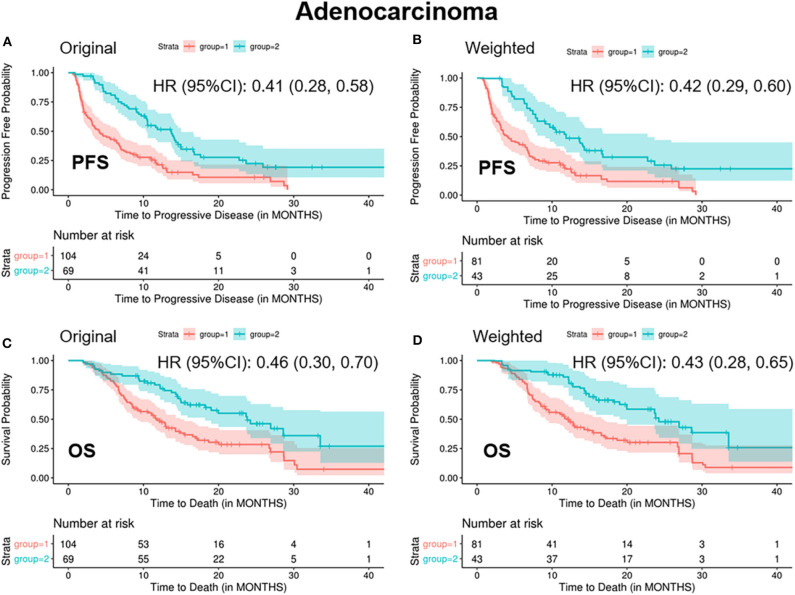
Kaplan-Meier curves of PFS/OS in the original and weighted sample of adenocarcinoma. group 1: meaningful improvements in <2 out of 4 biomarkers (CEA, CA125, CYFRA21-1, and SCC-Ag); group 2: meaningful improvements in ≥2 out of 4 biomarkers (CEA, CA125, CYFRA21-1, and SCC-Ag). Kaplan-Meier curves of (A,C) were based on the original sample; Kaplan-Meier curves of (B,D) were based on the weighted sample.